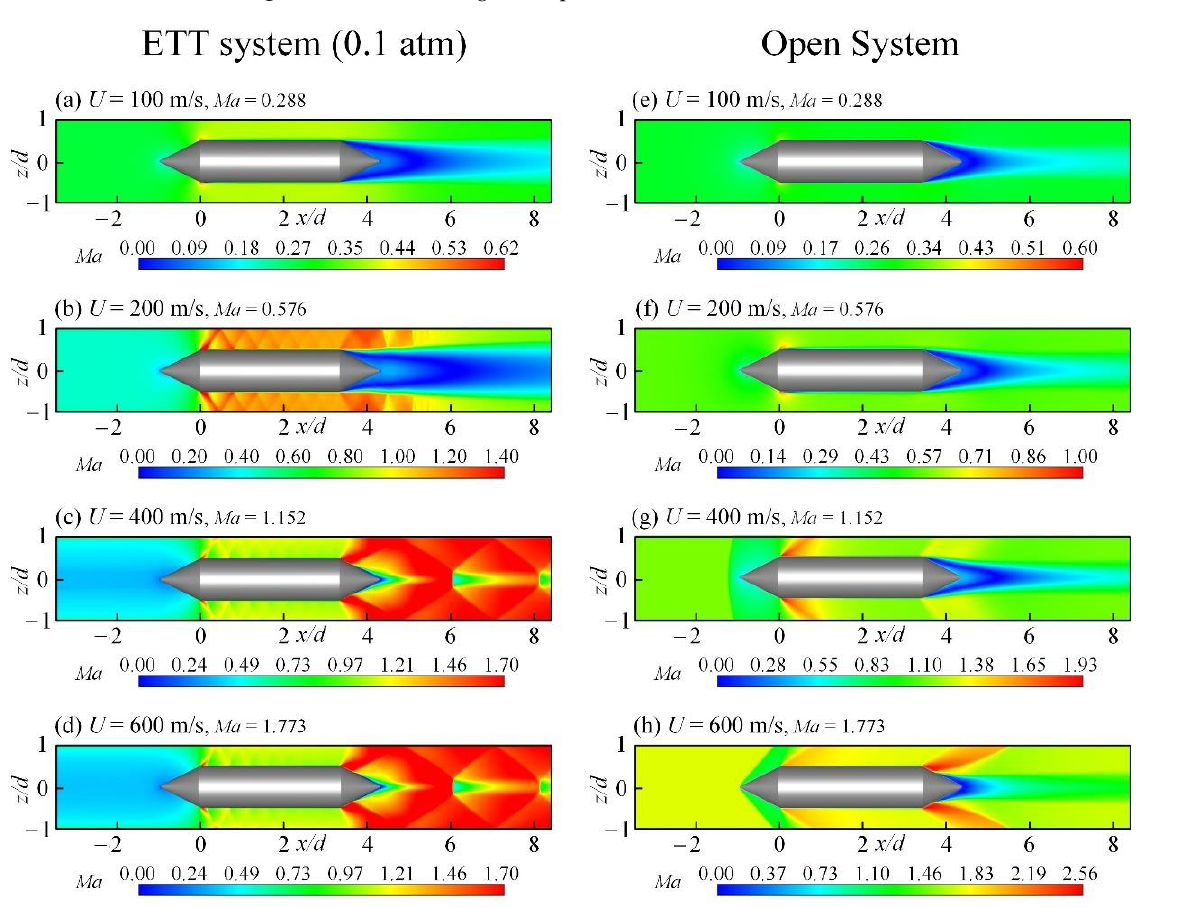
Figure 8. Mach number contours in the ( x, z ) plane at y = 0: 0.1 atm ETT system ( Left ) and 1 atm open system ( Right ).